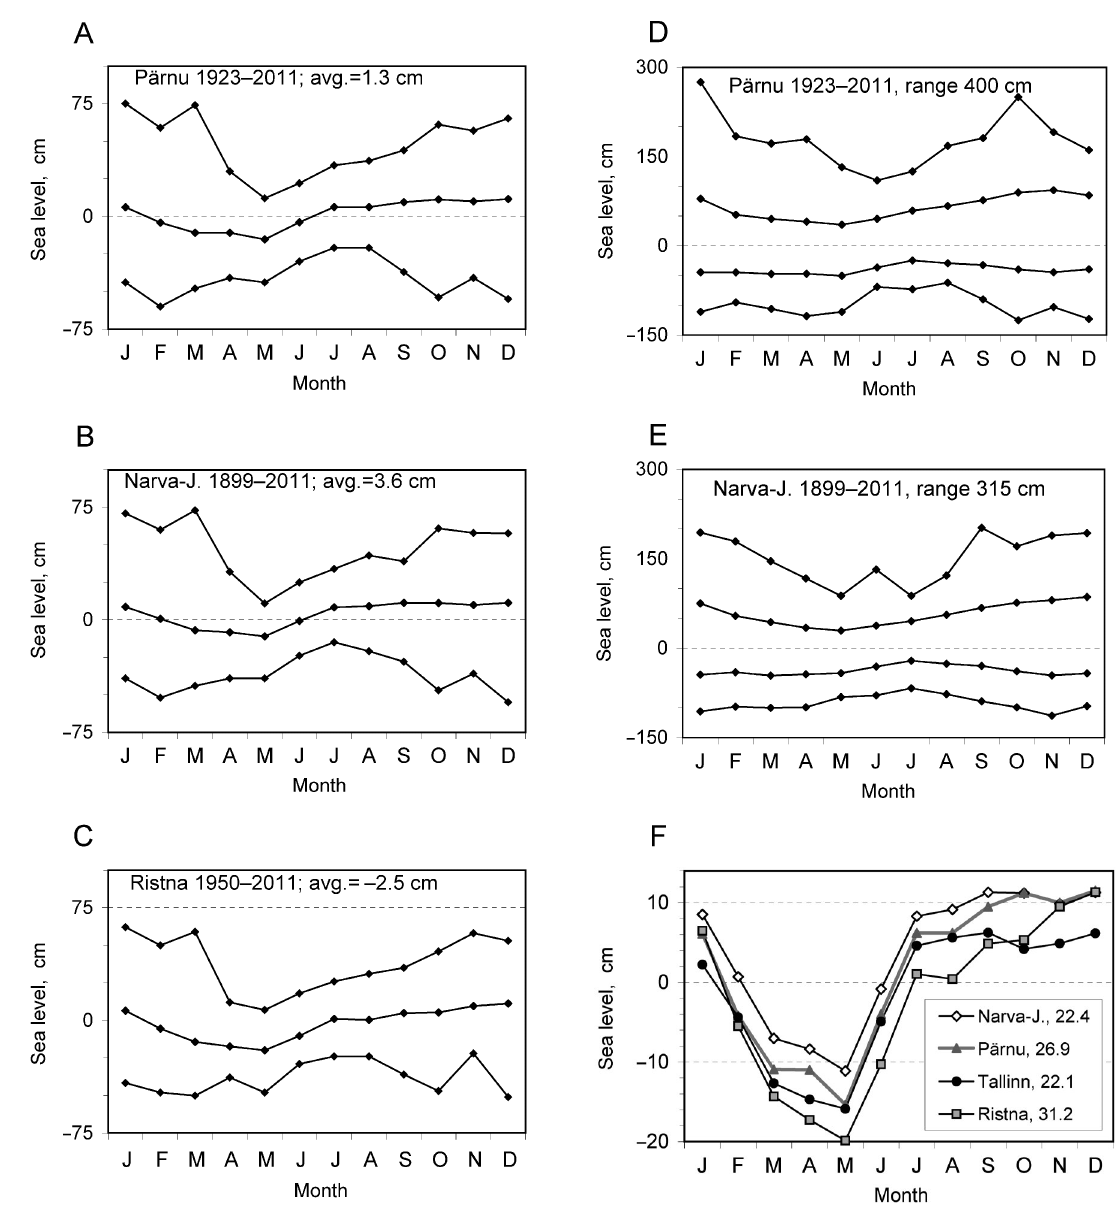
Fig. 5. Seasonal variations in monthly sea level statistics: ( A (cid:150) C ) from the top: maximum averages, averages and minimum averages; ( D , E ) absolute maximum, average maximum, average minimum and absolute minimum; ( F ) averages in four tide gauges (variation ranges of monthly averages are given in the